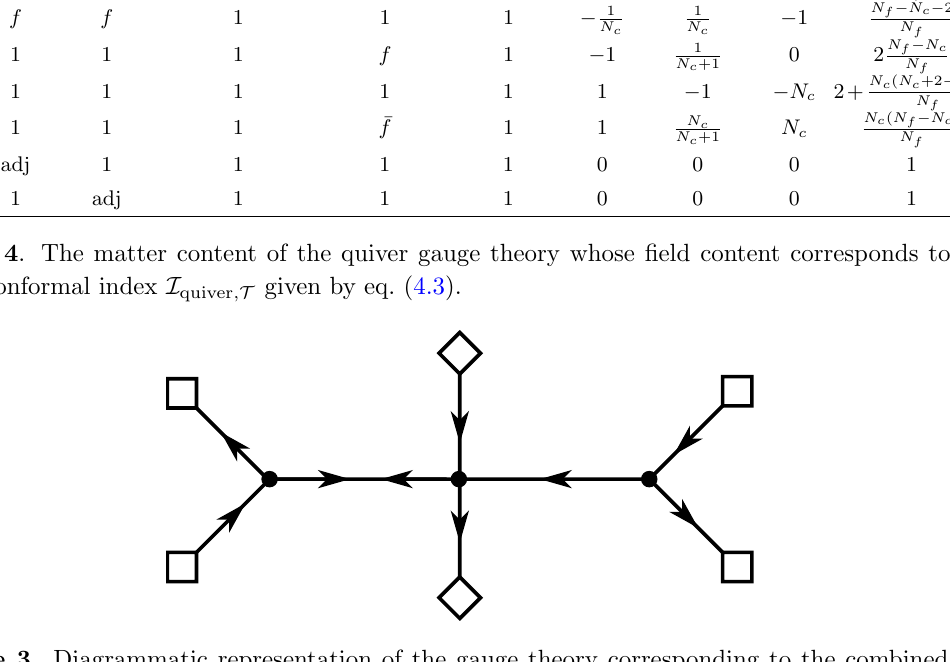
Figure 3 . Diagrammatic representation of the gauge theory corresponding to the combined ST quiver of eq. (2.27). The integration variables corresponding to the nodes (ordered from left to right) are y , z and w